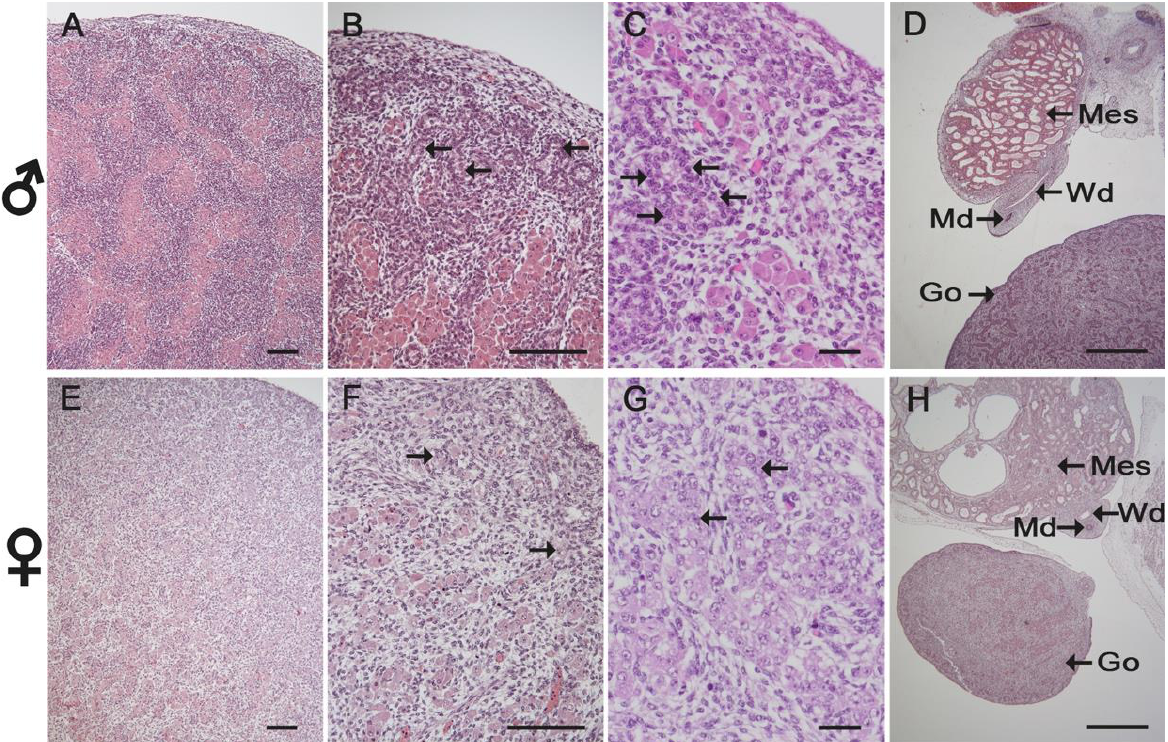
Figure 3. Histology (H&E staining) of male ( A – D ) and female ( E – H ) gonads and genital ducts in horse fetuses at 60 days of gestation. Seminiferous tubules (arrows in B , C ) were already developed in males and evenly distributed within the gonad ( A – C ). The female gonad presented cord-like clusters of large epithelioid cells (arrows in F , G ) mainly at its periphery ( E – G ). Abbreviations: Go, gonad; Wd/Md, Wolffian (mesonephric) duct/Müllerian (paramesonephric) duct; Mes, mesonephros. Scale bars in ( A , B , E , F ): 100 µm; C and G : 50 µm; D and H : 500 µm.